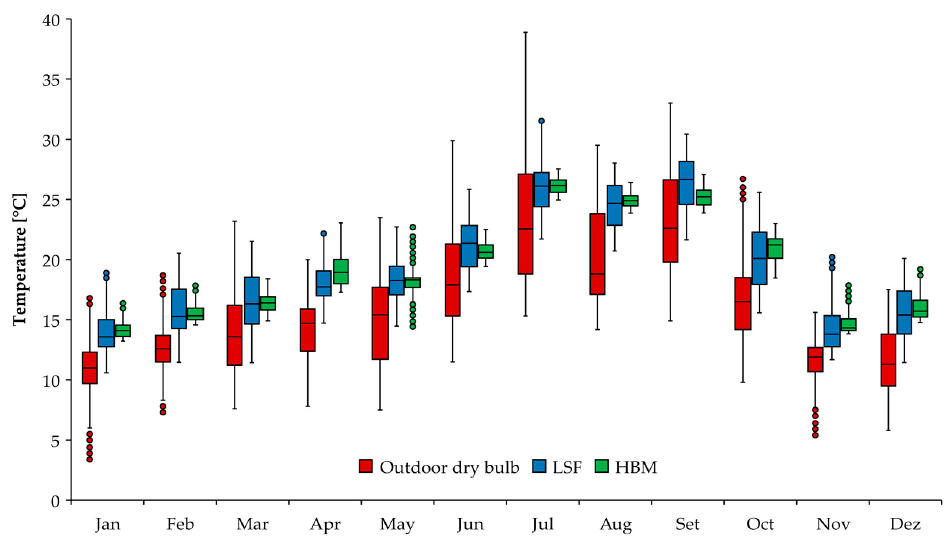
Figure 6. Monthly box plot representation of the indoor air temperature and outdoor dry-bulb tem- perature.